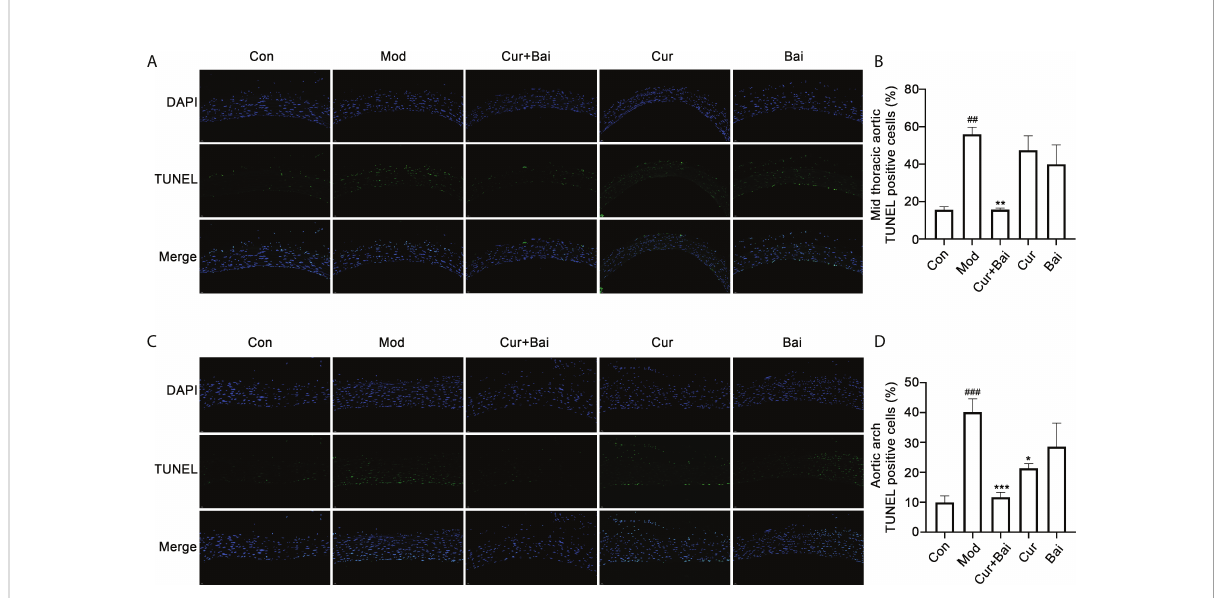
FIGURE 5 TUNEL staining for the mid thoracic and aortic arch blood vessel tissue in the control, model Cur+Bai, Cur and Bai treated groups. Represent TUNEL staining images of blood vessel in thorax (A) and heart (B) . Statistical analysis of the TUNEL positive cells in the mid thoracic (C) and aortic arch (D) . ## p <0.01, ### p <0.001 vs. control group. * p <0.05, ** p <0.01, *** p <0.001 vs. model group. Results were expressed as mean ± SEM for fi ve rats per group. The p values were obtained from one-way ANOVA